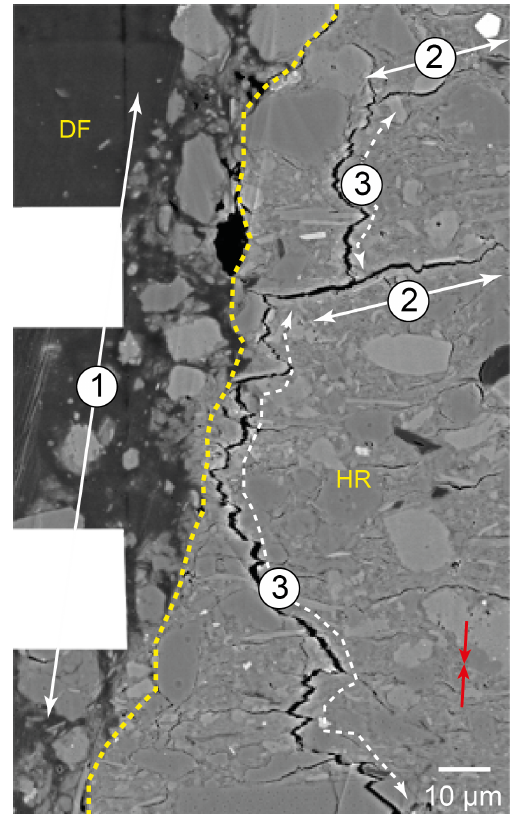
Figure 8. Detailed microstructure close the main fracture (indicated by number 1) in sample COX-2MPa. The main fracture displays in- ternal damaged fabric made of fragments of broken non-clay min- erals and clay matrix. Close to the main synthetic fracture, the host rock displays jagged joints subparallel to the main synthetic frac- ture (indicated by number 3) starting and ending at the antithetic fracture (indicated by number 2). In all micrographs, the orientation of the principal stress ( σ 1 ) is indicated by red arrows. The bedding is perpendicular to σ 1 . The dashed yellow line indicates the bound- ary between the damaged fabric (DF) and the host rock (HR).